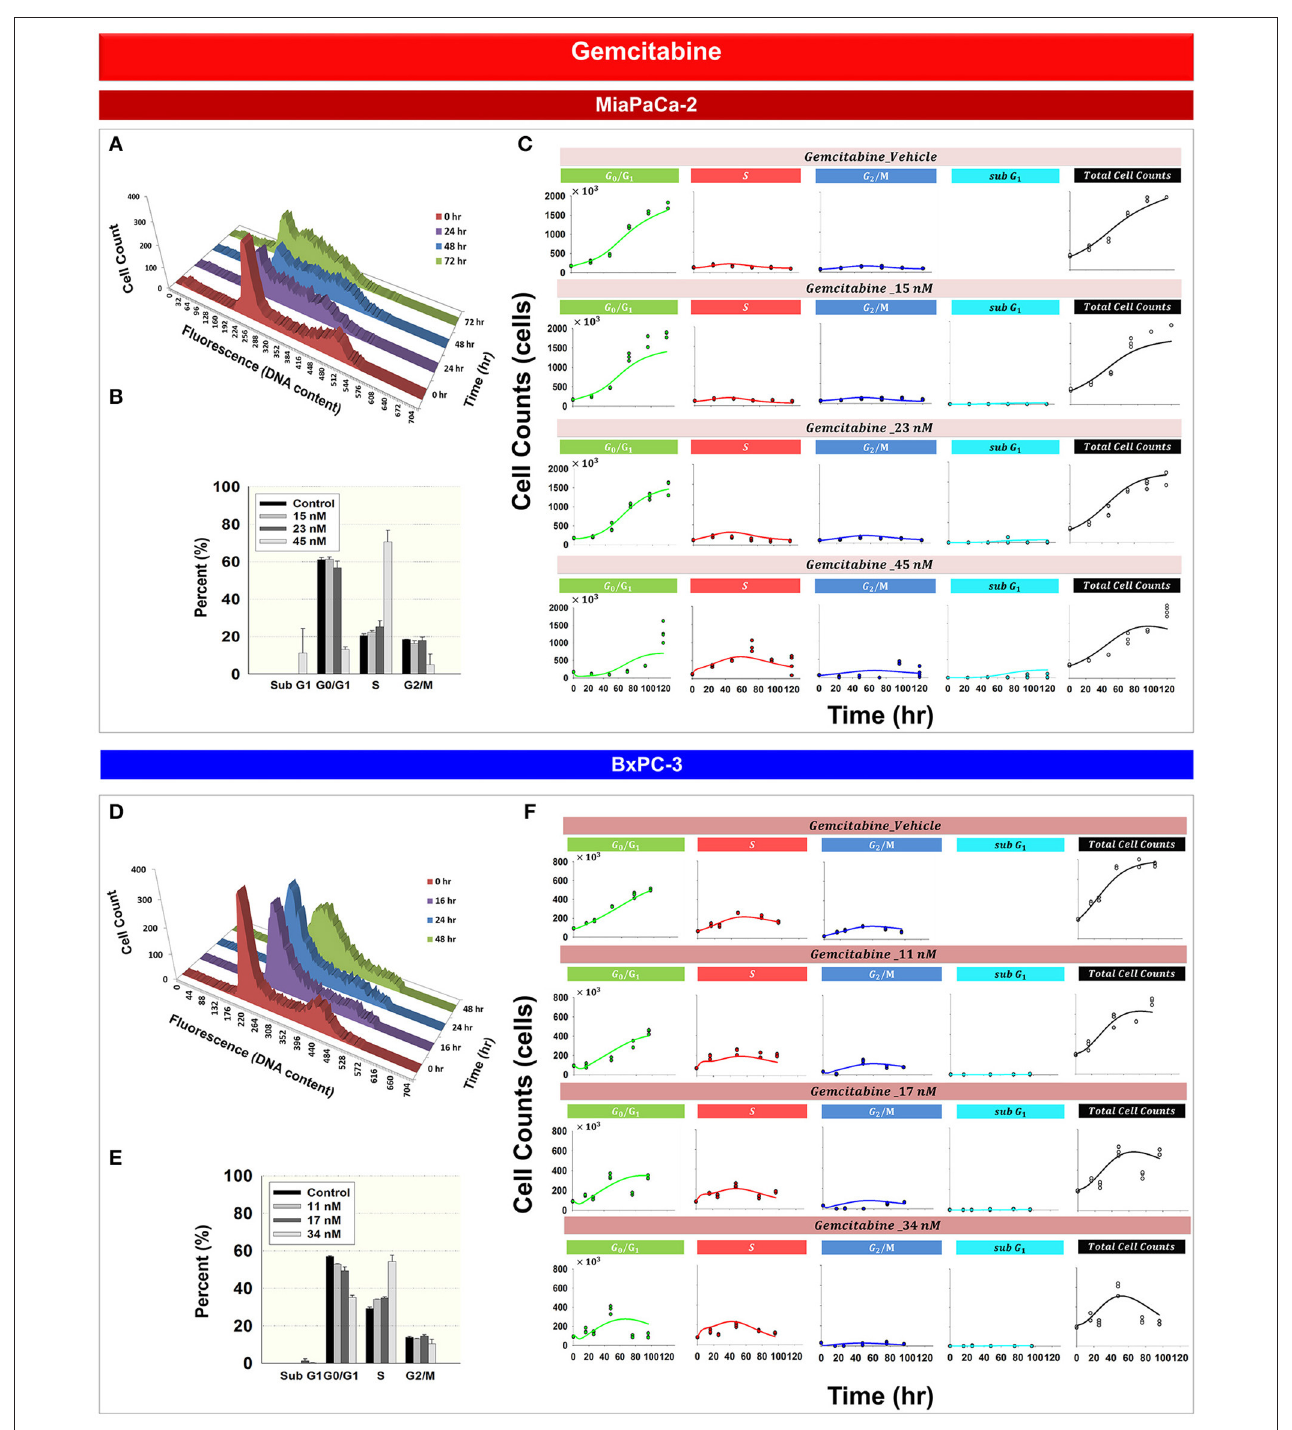
FIGURE 3 | Gemcitabine effects on the cell cycle for MiaPaCa-2 and BxPC-3 cells. (A,D) Histograms showing temporal changes in cellular DNA content after incubation with 45 nM gemcitabine in MiaPaCa-2 cells and 34 nM in BxPC-3 cells. All data are in triplicate. (B,E) fraction of cells in subG 1 , G 0 / G 1 , S , and G 2 / M phases after incubating cells with concentrations of gemcitabine shown for 48 (MiaPaCa-2) or 76 (BxPC-3) h. Columns , mean of triplicate determinations; bars , SD. (C,F) Data and model fitting results of cells incubating cells with concentrations of gemcitabine shown for up to 120 h. Symbols represent data for cells numbers in G 0 / G 1 , S , G 2 / M , subG 1 phase as well as total cell numbers; lines show model fittings based on PD models in Figure 1C (MiaPaCa-2) and Figure 1D (BxPC-3).